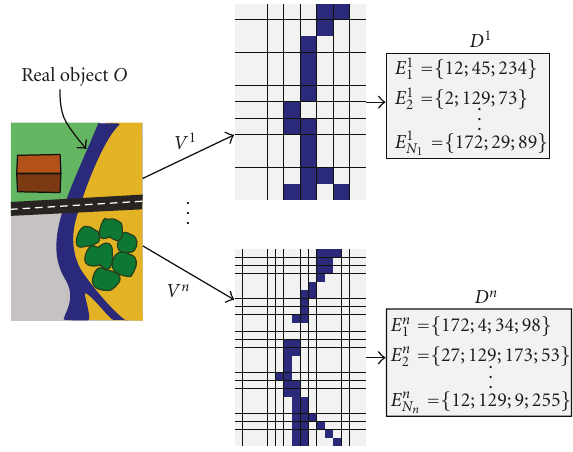
Figure 3: Di ff erent points of view V 1 to V n on a same object O (the river) producing di ff erent descriptions D 1 to D n of the object.